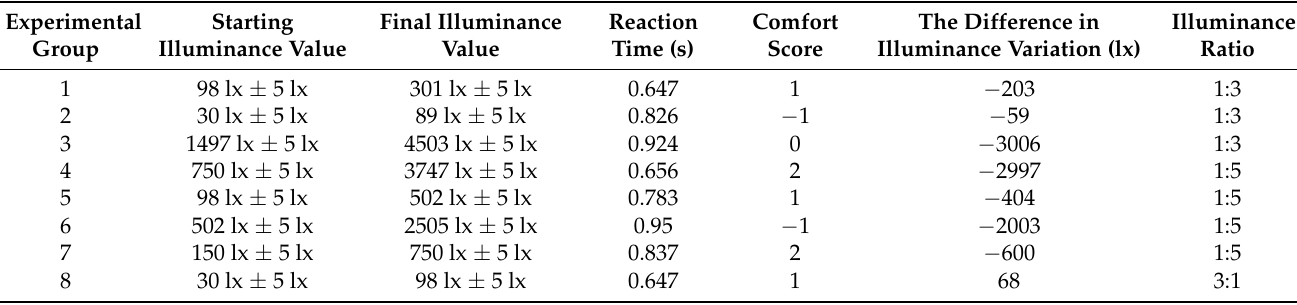
Table 3. Partial experimental data